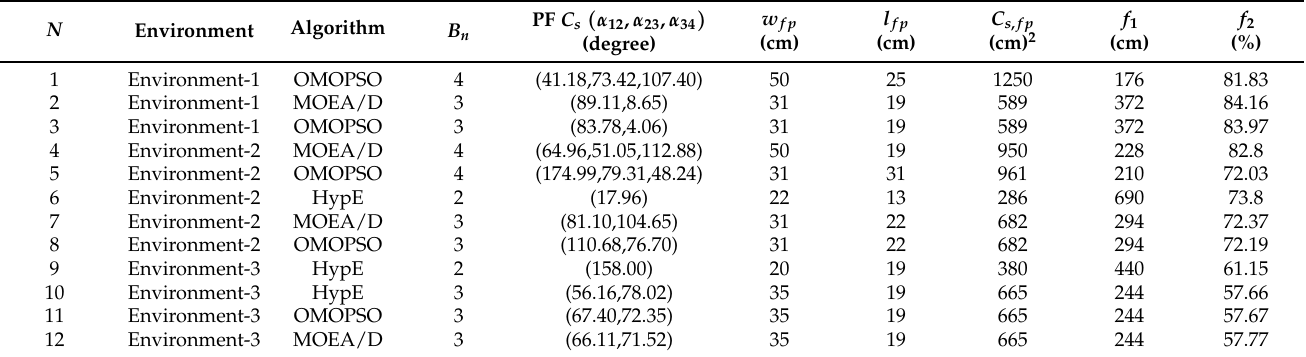
C s : is the configuration space defined by angles α 12 , α 23 , α 34 in degrees (refer Figure 4); C s , fp : Footprint area by the configuration space, PF C s : Pareto front configuration